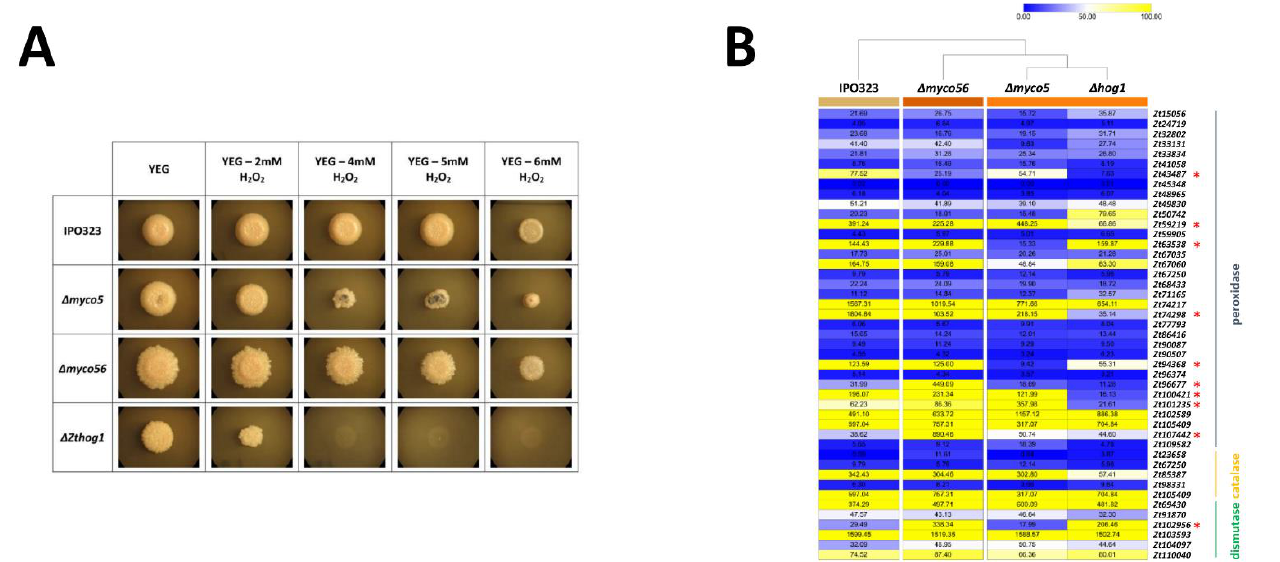
Figure 7. Susceptibility of mutant strains to oxidative stress. ( A ) Morphologies of colonies of Z. tritici IPO323 and the mutants generated in the current study under oxidative stress. Wild-type strain and mutant strains were spotted as 1.5 μL spots from a 5 × 10 7 spores/mL spore suspension and grown on YEG agar medium, with the concentrations of H 2 O 2 indicated. Plates were documented following 7 days’ growth at 18 °C. ZtHOG1 is more susceptible to oxidative stress, while ∆ myco5 has a slightly reduced growth. ( B ) Transcription of the potential (chloro)peroxidases, catalase and superoxide-dismutase-encoding genes identified by using RNA-Seq data. Gene-expression data were clustered in one dimension by hierarchical agglomerative clustering with complete linkage. One minus Pearson correlation was used as the similarity metric for the Z. tritici strains. The detected expression profiles reveal, on average, a lower expression of listed genes in the case of ∆ myco5 and ∆ Zthog1 , while ∆ myco56 was the highest. Red asterisks (*) show DE transcripts with significantly changed transcription in at least two strains.